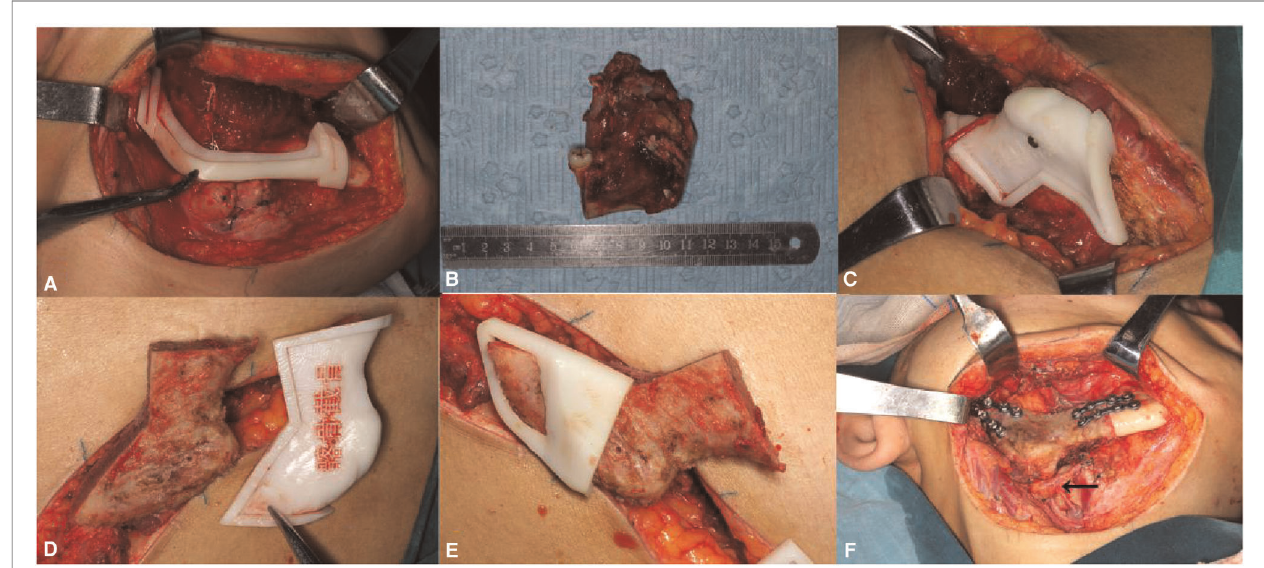
FIGURE 4 | According to the surgical cutting guide, the right mandible from 47 to the condylar neck was resected ( A , B ); and the vascularized iliac fl ap was harvested and prepared ( C – E ). The prepared vascularized iliac fl ap was fi xed to the mandible to reconstruct the mandible defect by a titanium plate according to the fi xation guide, and the deep circum fl ex iliac artery (DICA) and the deep circum fl ex iliac vein (DICV) were anastomosed with facial artery and external jugular vein; the arrow shows that the vessel pedicle was in a line when the iliac bone fl ap was transferred to the mandible defect area ( F ).